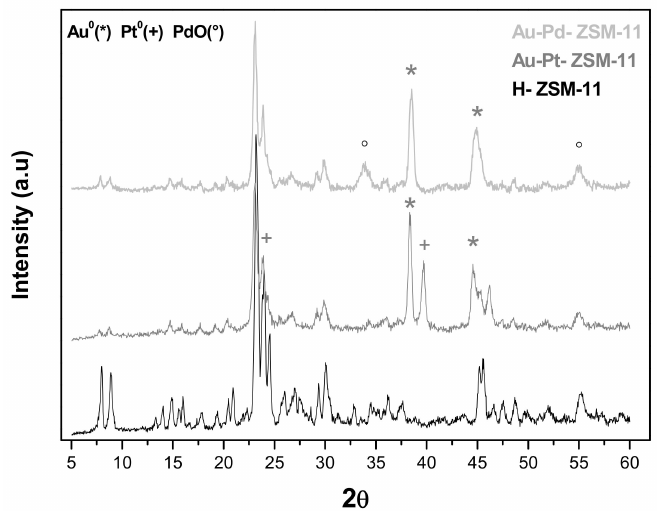
Figure 2. X-ray diffraction (XRD) patterns of bimetallic catalysts Au-Pt-ZSM-11 and Au-Pd-ZSM-11, compared to the pristine H-ZSM-11